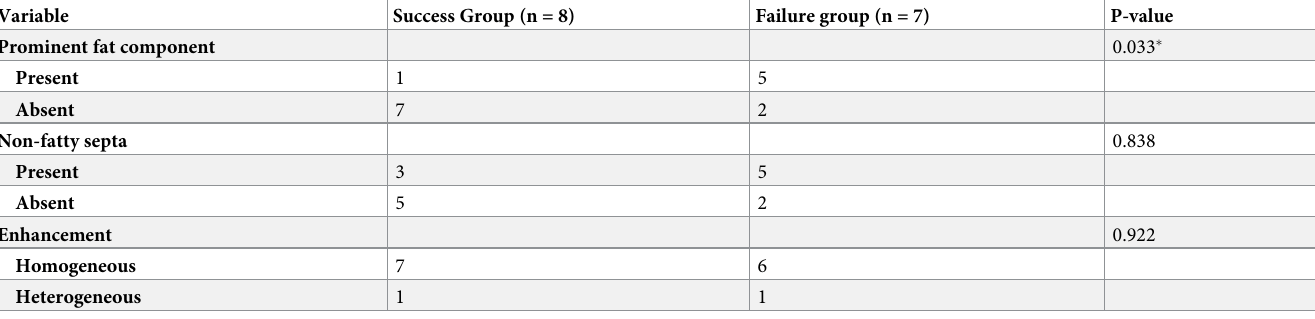
Table 4. Pre-treatment MR imaging findings according to successful treatment.